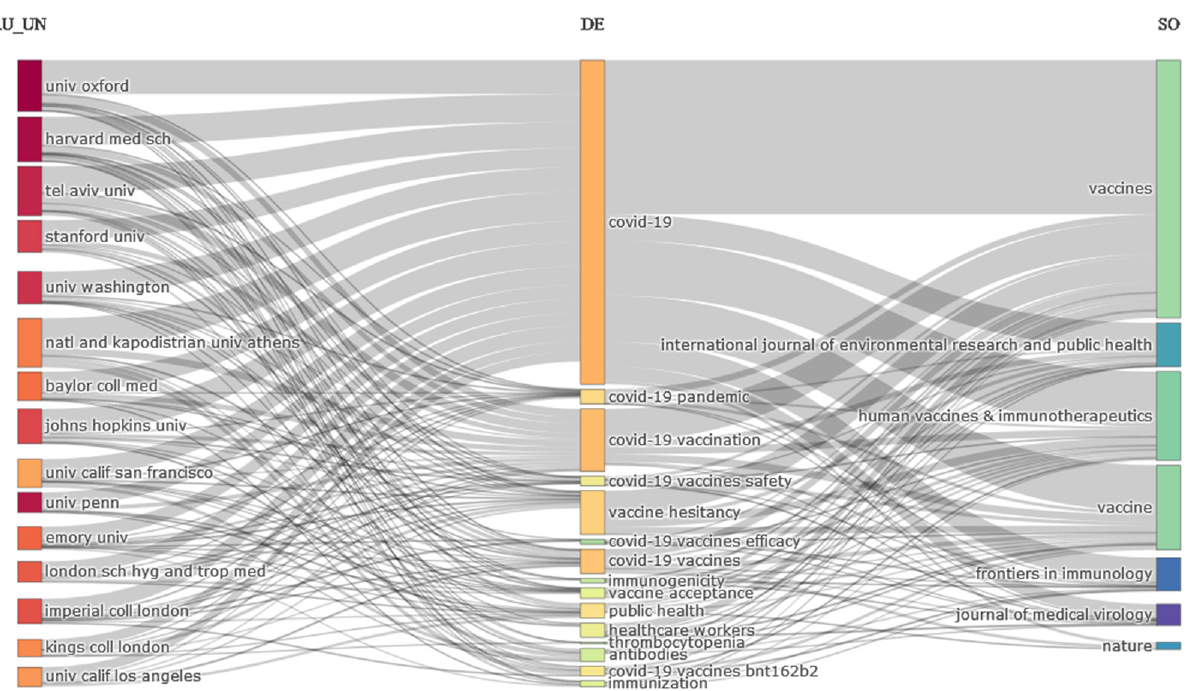
Figure 6. Three-field plot of the relationships between institutions, authors’ keywords, and sources in the research of the COVID-19 vaccine. (AU_UN: Author university, DE: keyword, SO: Source).